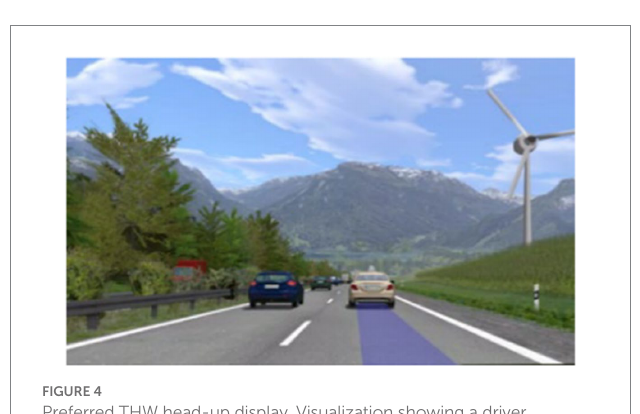
FIGURE 4 Preferred THW head-up display. Visualization showing a driver preferred time headway of 0.4 s and a front vehicle at the same